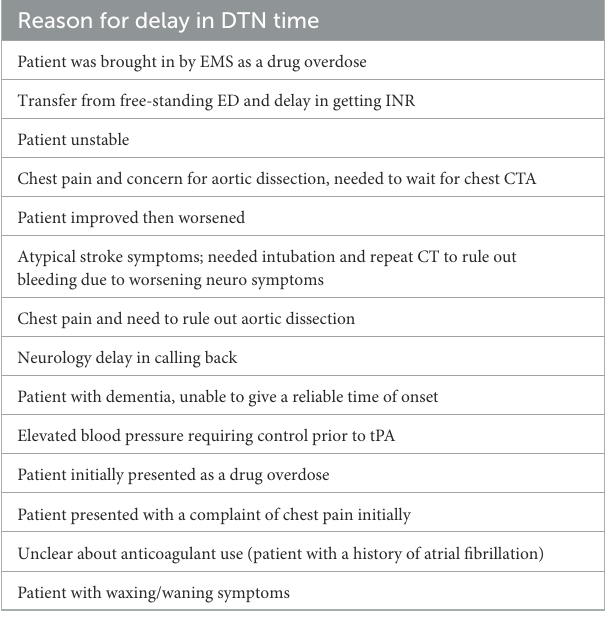
TABLE 2 Reasons for delay in door-to-needle (DTN)